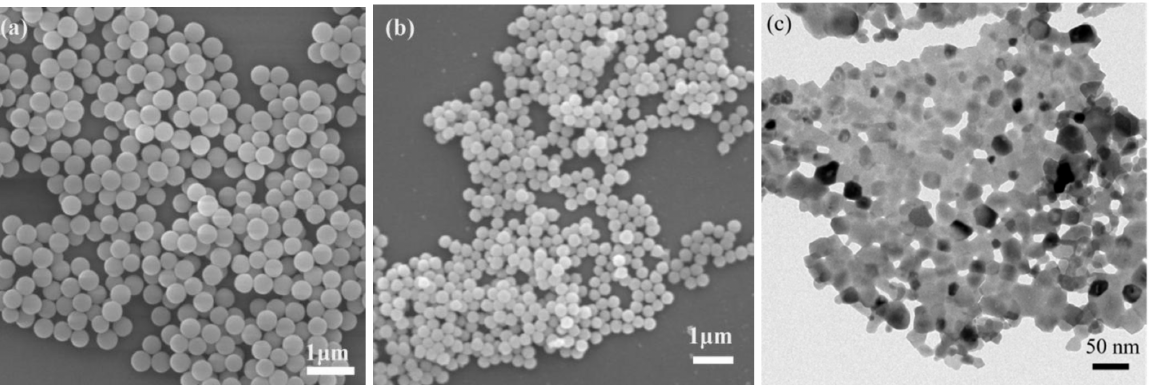
Figure 1. Micrographs showing particle morphologies of the Y 2 O 3 precursor ( a ) and calcined at